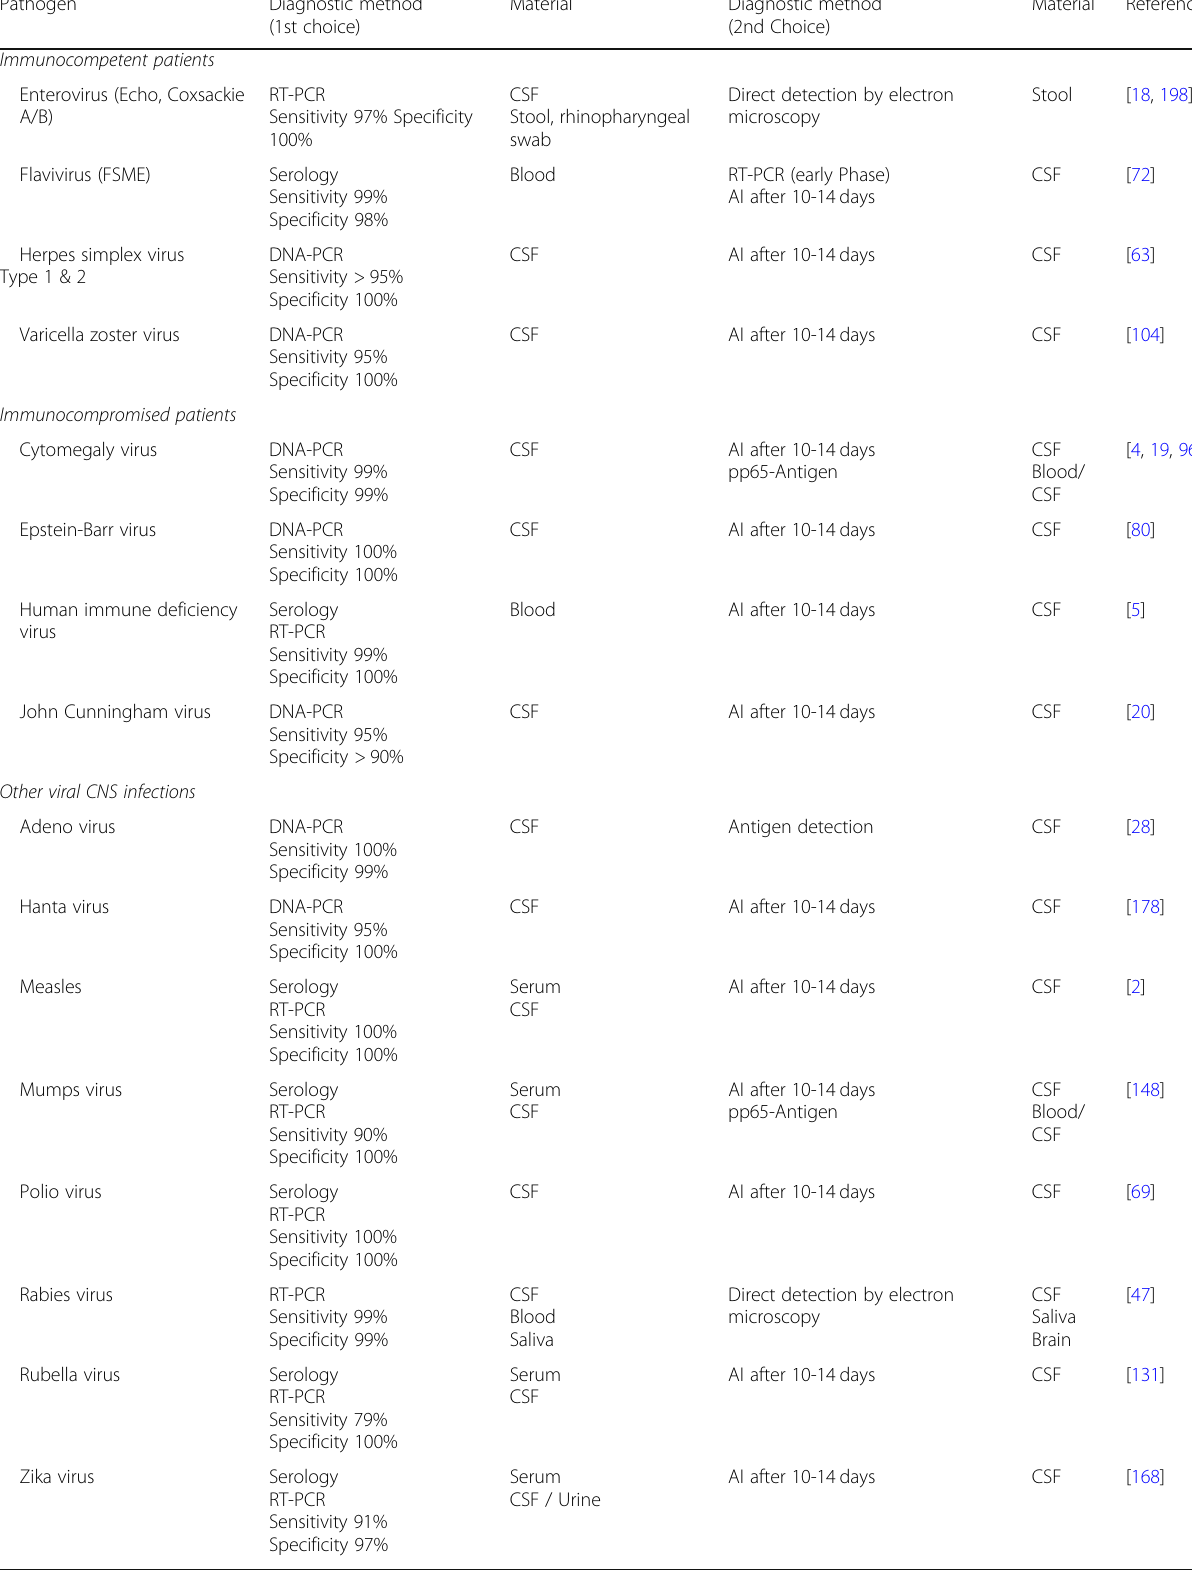
Table 8 Spectrum of viral pathogens and diagnostic methods